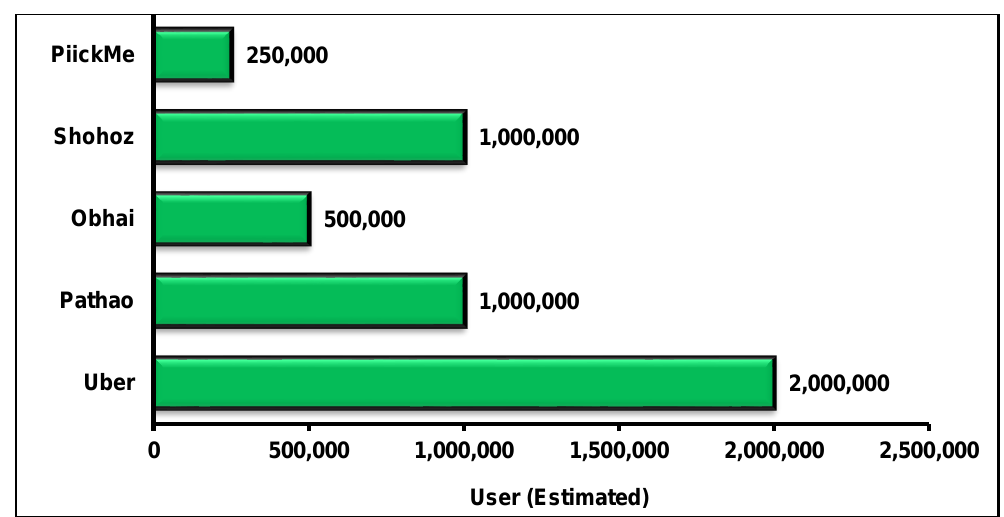
Fig. 4. User compliance in Bangladesh for each ride-sharing